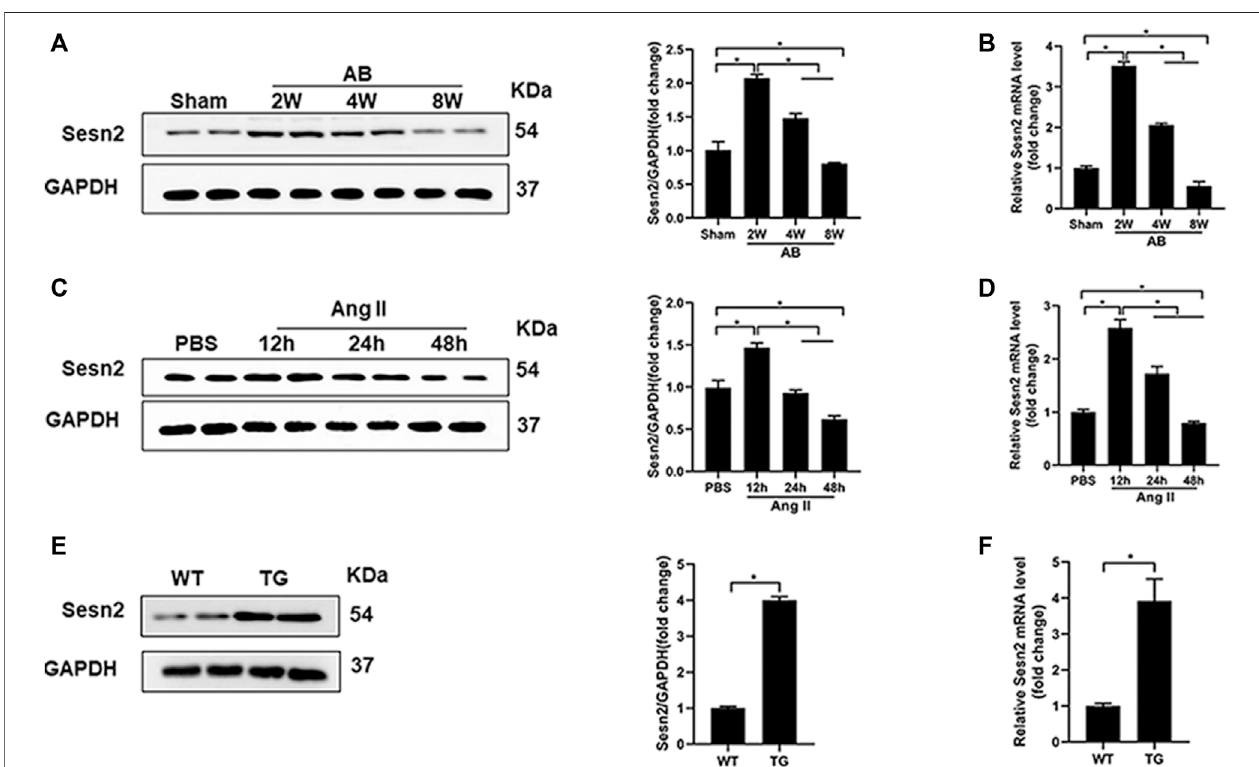
FIGURE1| TheexpressionofSesn2inhypertrophicheartsandAngII-inducedcardiomyocytes. (A) RepresentativeimmunoblotsandquantitativeresultsofSesn2 proteinexpression inmice heartsat 2,4,and 8 weeksafter ABsurgery( n (cid:1) 6). (B) qPCR analysisofthe mRNAlevels ofSesn2at2,4, and8 weeksafter ABsurgery ( n (cid:1) 6). (C) RepresentativeWesternblotsandstatisticalanalysisofSesn2expressioninNRCMsat12,24,and48 hafterAngIItreatment( n (cid:1) 6). (D) Sesn2mRNAexpression levels in NRCMs treated with or without Ang II stimulation ( n (cid:1) 6). (E) Representative Western blots and statistical analysis of Sesn2 expression in the hearts of WT and TG mice, respectively ( n (cid:1) 6). (F) Sesn2 mRNA expression in WT and TG mice hearts ( n (cid:1) 6). The data were expressed as the mean ± SD.* p < 0.05 vs. indicated group. One-way analysis of variance (ANOVA) followed by Tukey post hoc tests were used for signi fi cance